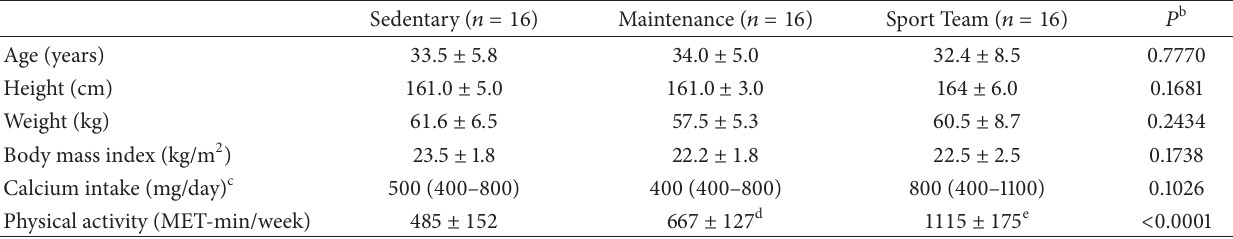
Table 1: Characteristics of participants a .